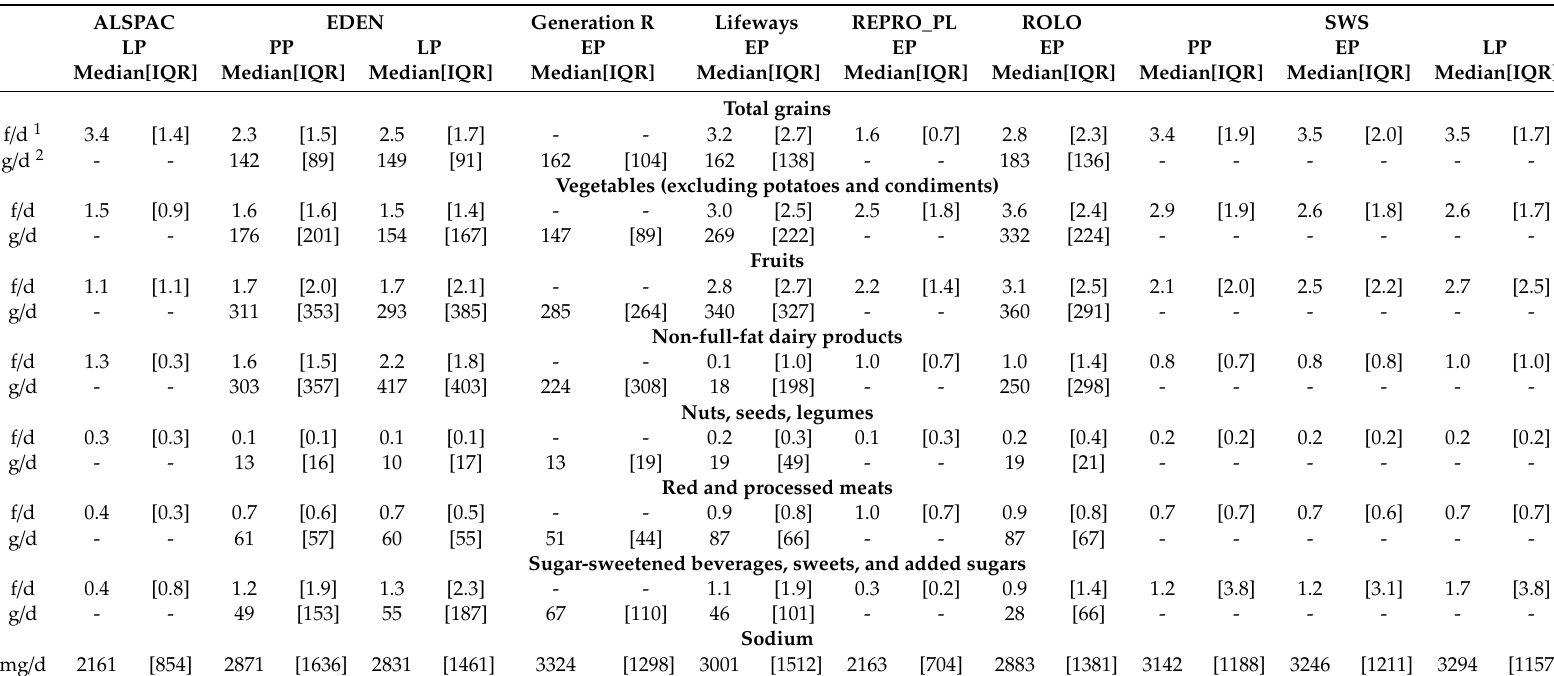
Table 4. Median intakes of DASH food components by cohort and period in the ALPHABET